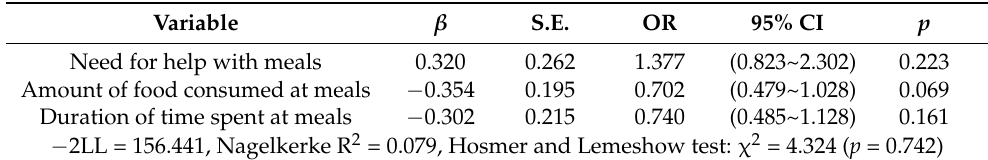
duration of time spent at meals, and nutritional status. Variable β S.E. OR 95% CI p Need for help with meals 0.320 0.262 1.377 (0.823~2.302) 0.223 Amount of food consumed at meals − 0.354 0.195 0.702 (0.479~1.028) 0.069